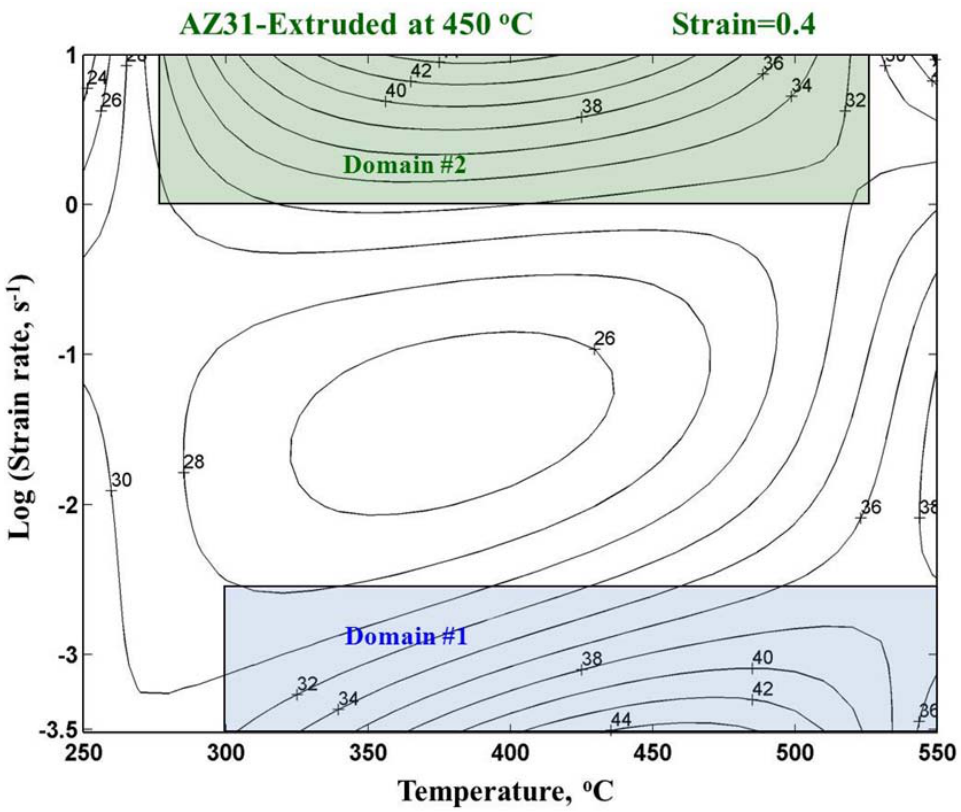
Figure 11. Processing map obtained at a strain of 0.4 for AZ31 magnesium alloy extruded at 450